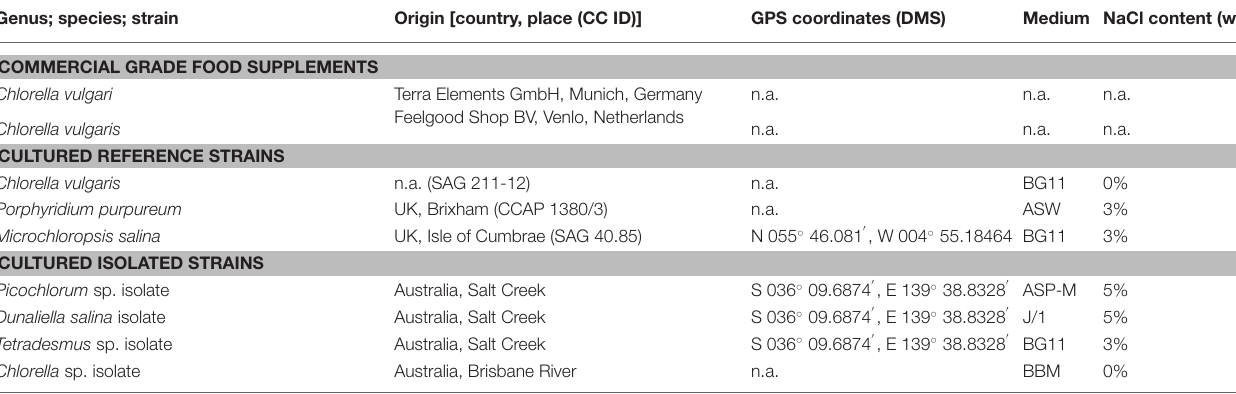
TABLE 1 | Overview of analyzed microalgae biomass. Genus; species; strain Origin [country, place (CC ID)] GPS coordinates (DMS) Medium NaCl content